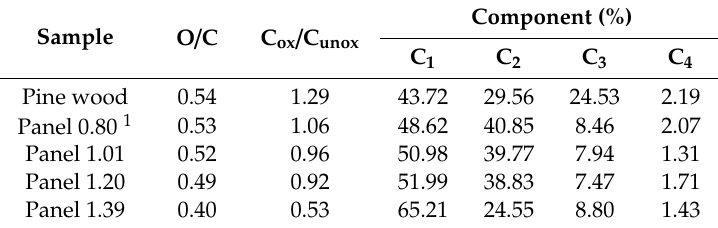
Figure 6. X-ray photoelectron spectroscopy (XPS) spectra of scrimbers with densities of ( a ) 0.80, ( b ) 1.01, ( c ) 1.20 and ( d ) 1.39 g/cm 3 . Table 2. Components of C1 s and O1 s on the scrimber surfaces.